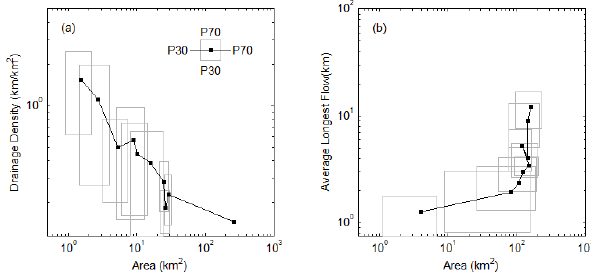
Fig. 4 Scaling property of watershed attributes associated with ranges of watershed areas 3 Fig. 4. Scaling property of watershed attributes associated with 4 ranges of watershed